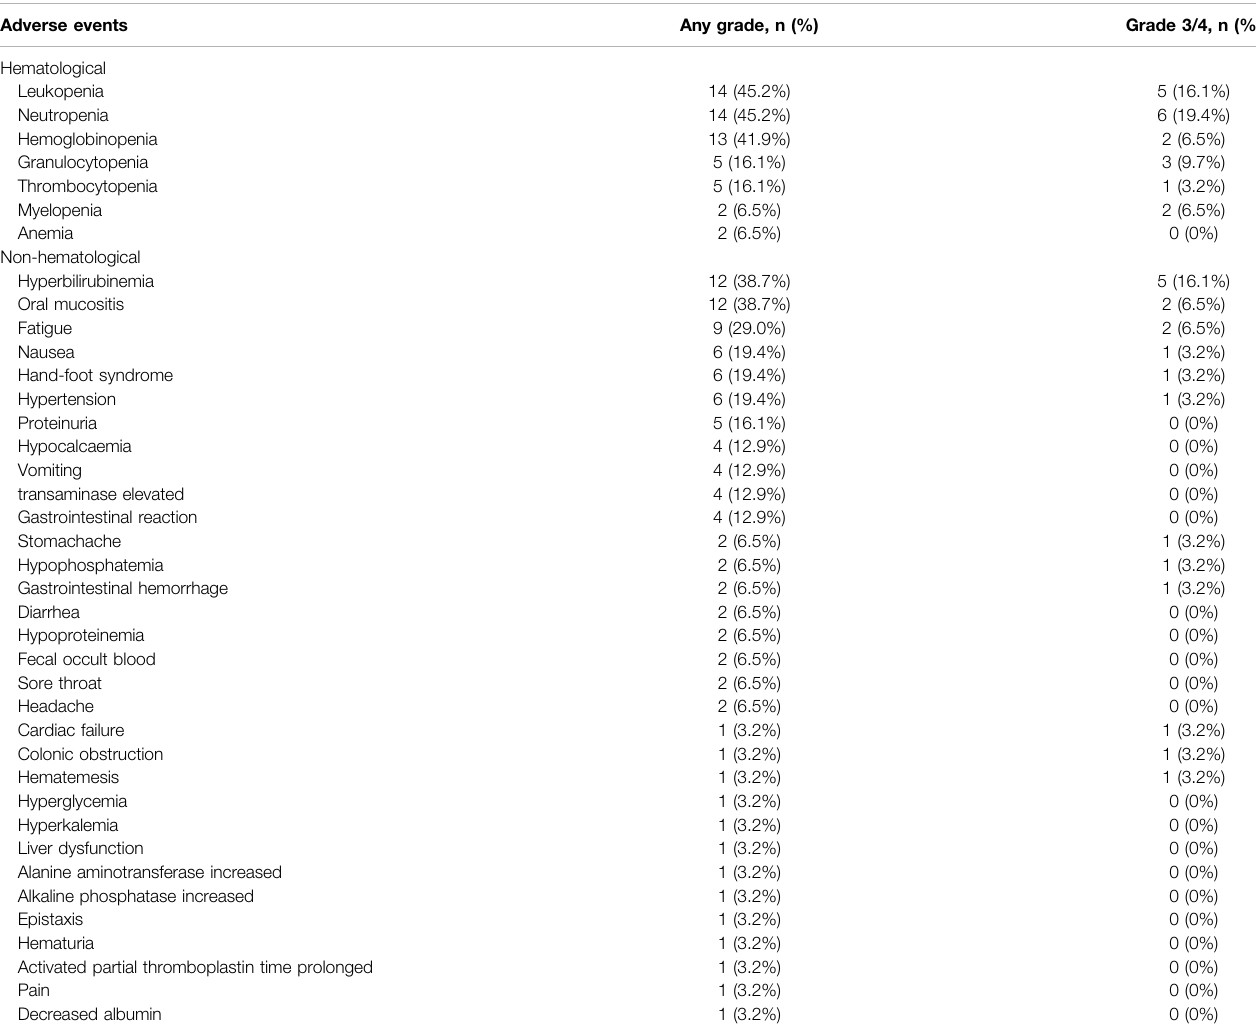
TABLE 2 | Incidence of adverse events during preoperative treatment. Adverse